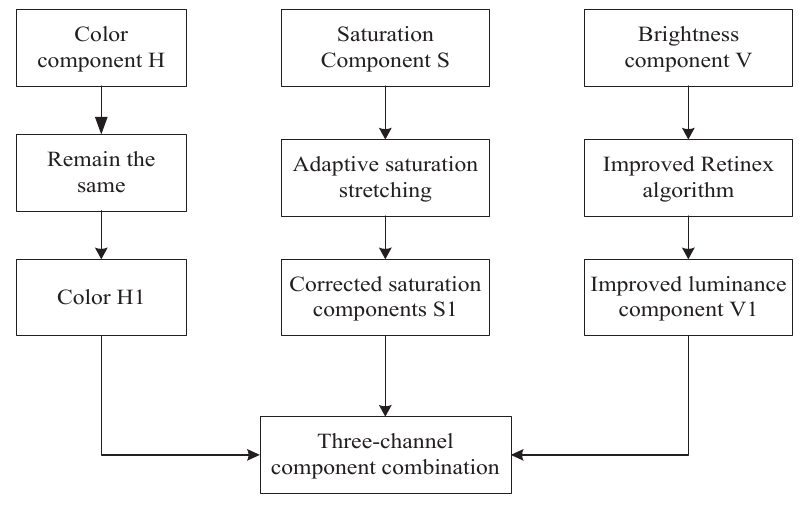
Figure 3. Network structure